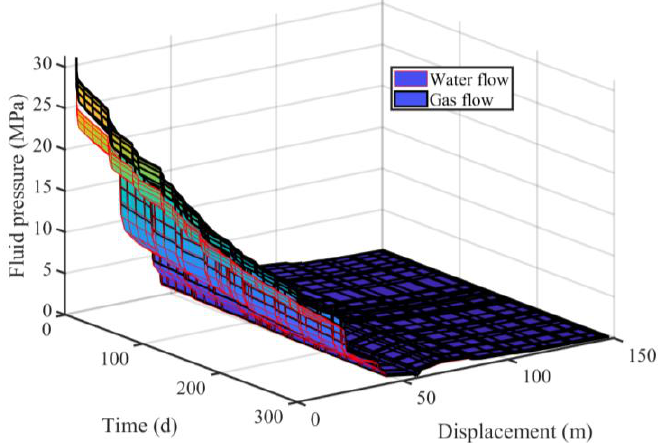
Figure 3. Pressure variations in a two-phase flow.